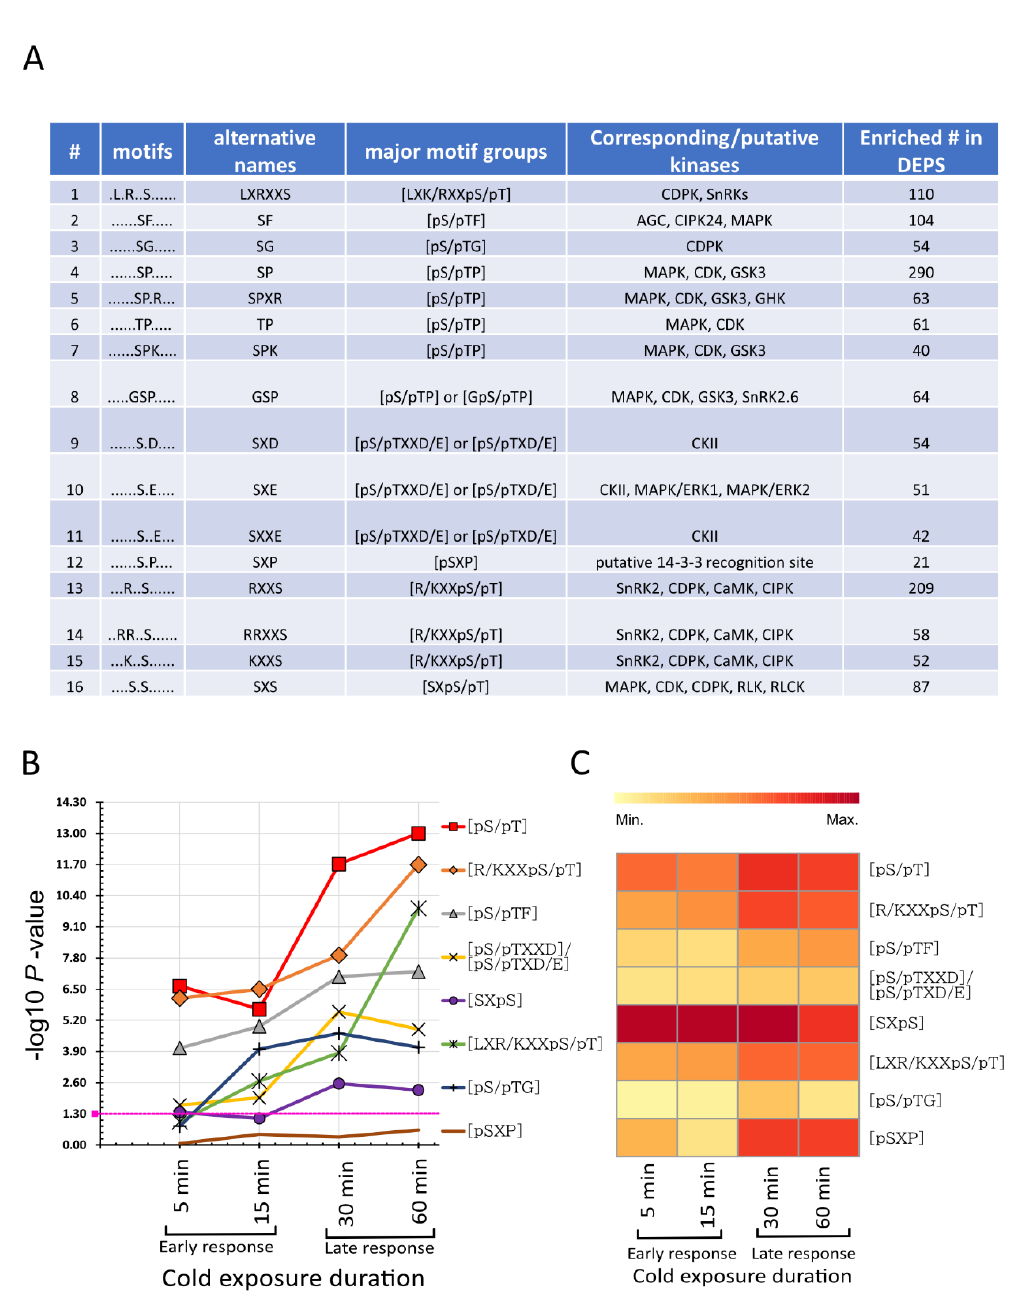
Figure 5. Cold-responsive phosphorylation kinase motifs. ( A ) Kinase motifs and major motif groups and their corresponding / putative upstream kinases. The numbers of corresponding motifs from the di ff erentially expressed phosphopeptides (DEPS) are listed. ( B ) Temporal changes in the motif dynamics in response to cold. The p -values were obtained by Fisher’s exact test using enriched motif counts in DEPS and the major motif groups mentioned in ( A ). ( C ) Time-dependent change in the relative abundance in the corresponding phosphopeptides of each major